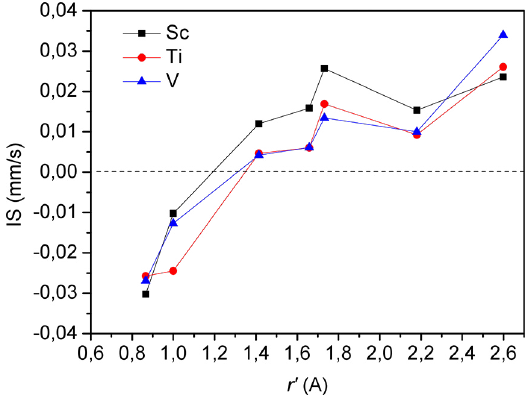
Figure 7. Isomer shift (IS) values at nonequivalent iron sites plotted as function of r’ . The dashed horizontal lines correspond to the IS value of α-Fe.